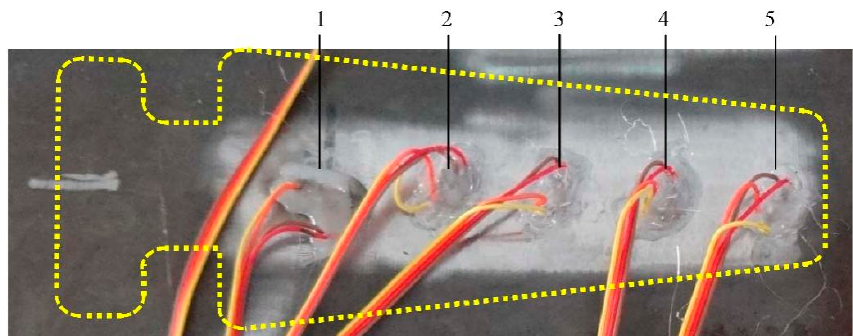
Figure 10. Strain gauges location.